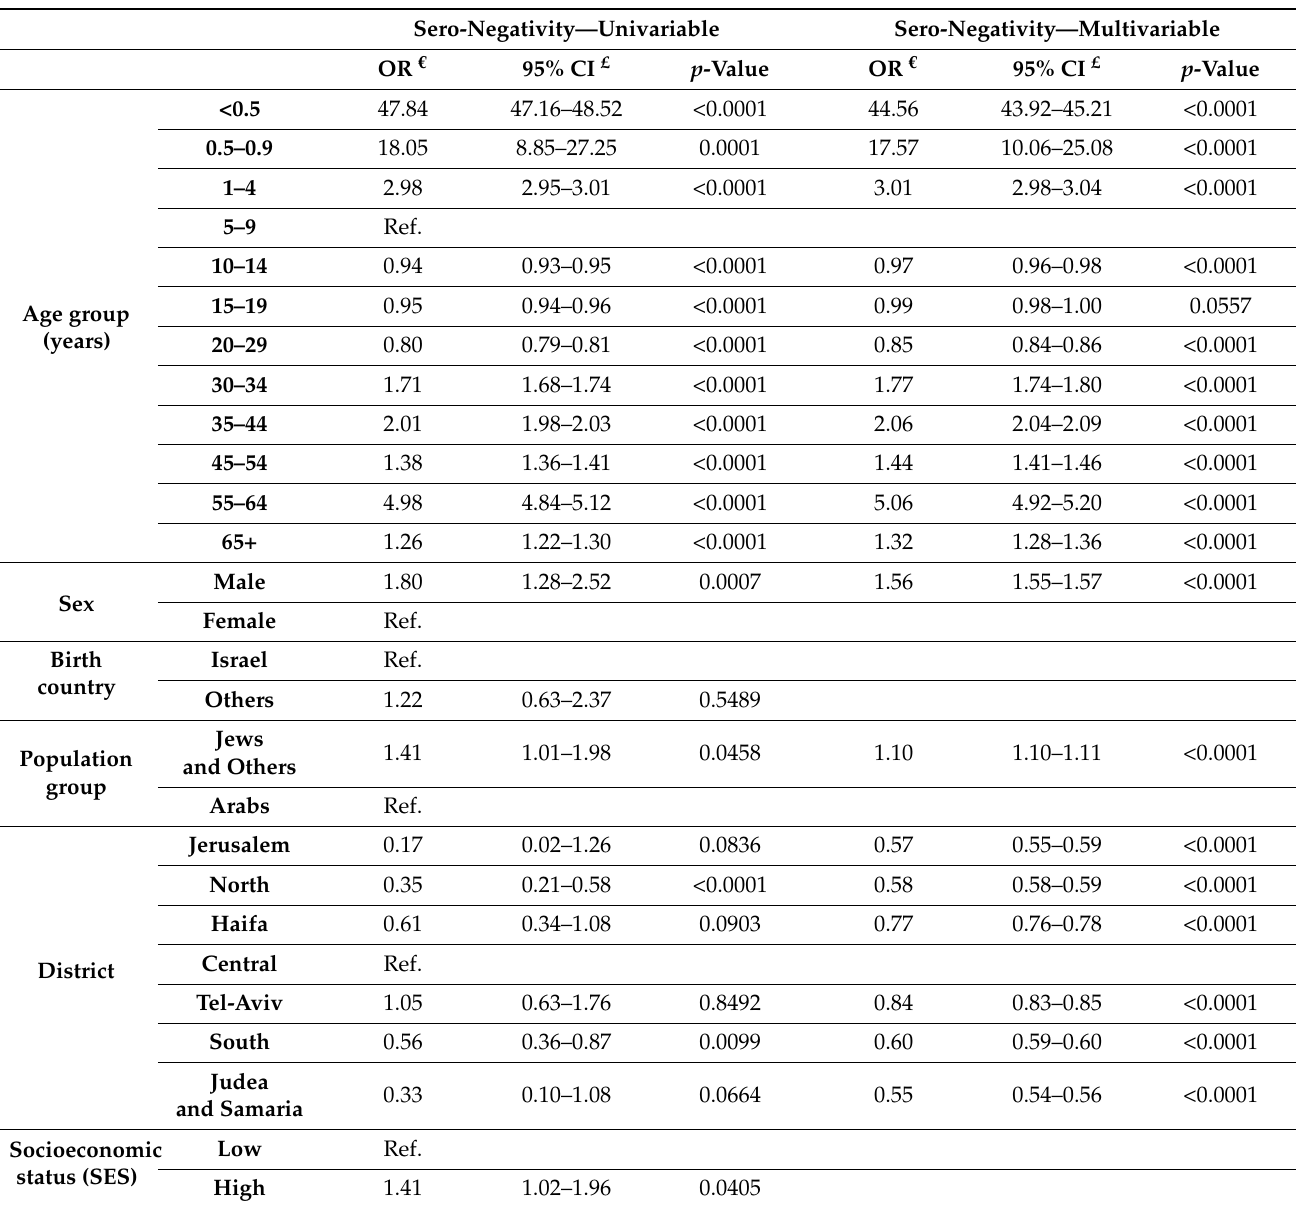
Table 4. The association between demographic characteristics and sero-negativity for rubella in Israel, 2015, univariable and multivariable analyses.